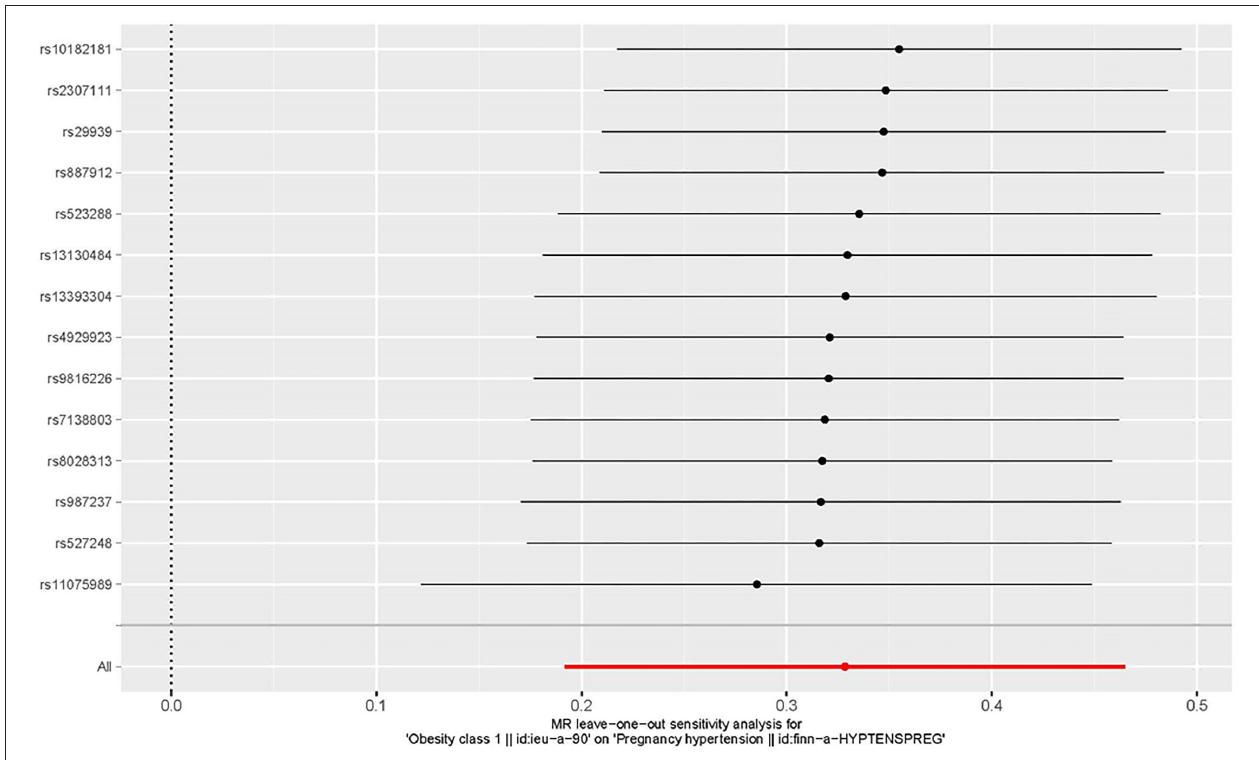
FIGURE 6 | The leave-one-out plot to visualize the causal effect of obesity on the risk of hypertension disorders in pregnancy when leaving one SNP